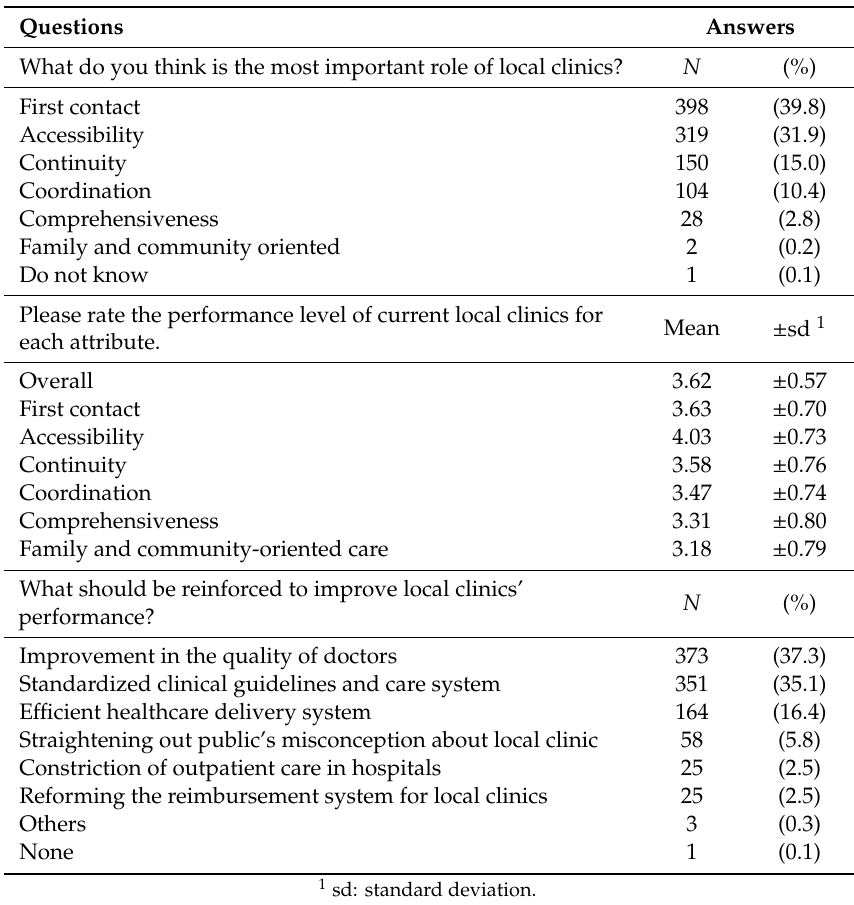
Table 6. General public’s assessment of current local clinics as primary care